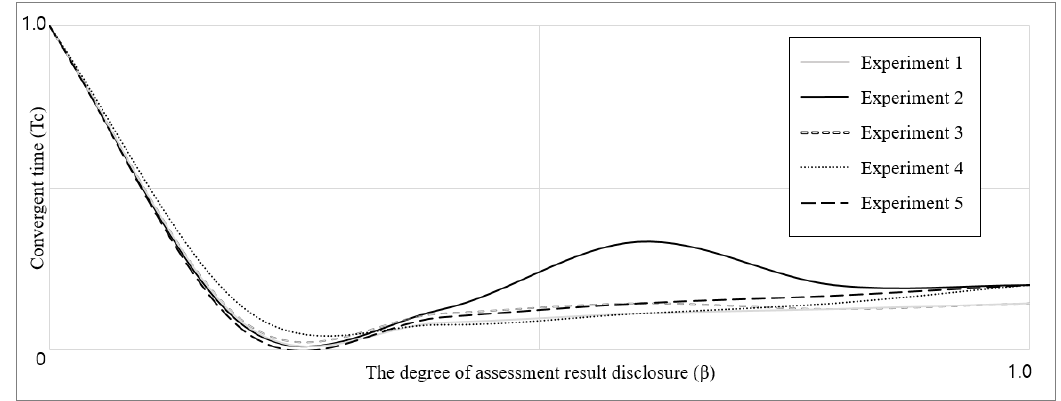
Figure 3. Comparison of convergence time between the different feedback policies.